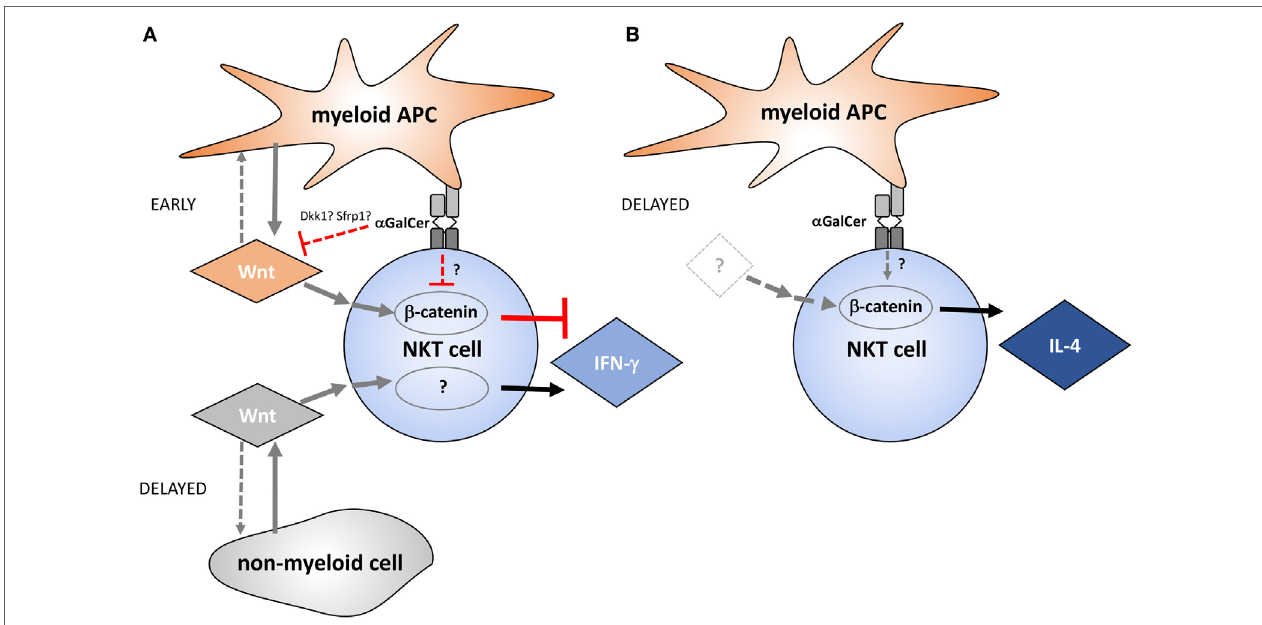
FigUre 7 | Proposed model of the temporal contributions of Wnt ligands and β -catenin to α -galactosylceramide ( α -GalCer)-induced interferon gamma (IFN- γ ) and IL-4 responses by liver natural killer T (NKT) cells. (a) Wnt production by myeloid cells and Wnt/ β -catenin signaling negatively regulate early IFN- γ expression by NKT cells during α -GalCer challenge. Within hours after α -GalCer exposure, Wnt ligand expression in the liver environment is largely suppressed. This is accompanied by increased expression of endogenous Wnt signaling inhibitors such as Dkk1 and Sfrp1 , as well as suppression of Tcf/Lef-driven transcriptional activity. Suppression of Wnt/ β -catenin signaling favors IFN- γ expression by NKT cells, which is partially supported by β -catenin-independent signaling events driven by Wnt ligands originating largely from non-myeloid cells. (b) β -catenin activity contributes to IL-4 expression by liver NKT cells independent of Wnt ligand production, at least during the first 6 h analyzed in the mouse model utilized here. While NKT cells are, in principle, equipped with the signaling machinery required to relay Wnt signaling via β -catenin-dependent and -independent pathways as depicted in this model, direct experimental evidence for contributions of these molecular networks in NKT cells is pending. Moreover, it is important to emphasize that the effects of Wnt pathway perturbation on NKT cell cytokine responses may also result from indirect effects of Wnt ligands on other cells, such as antigen-presenting cells (APCs), NK cells, and